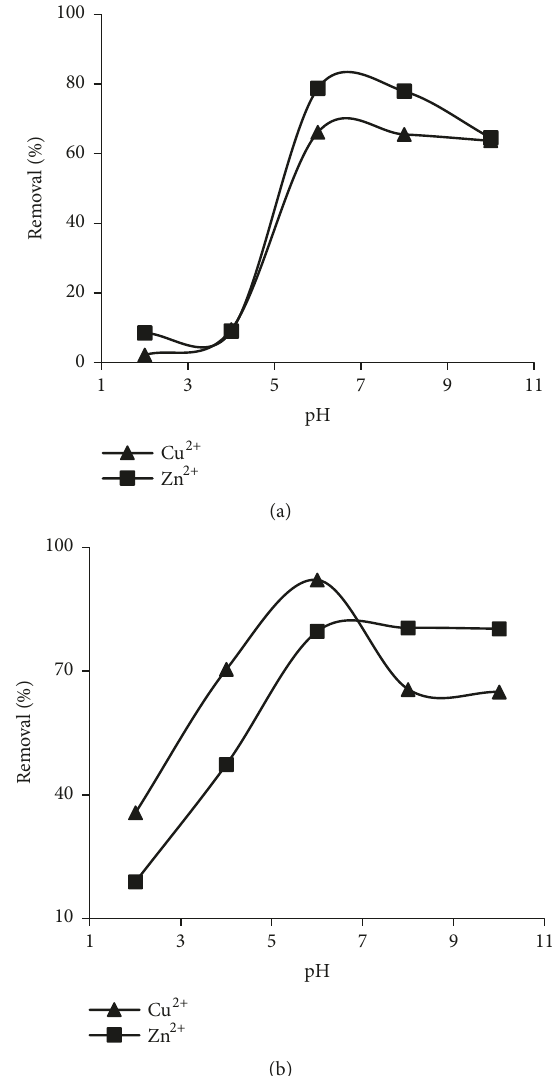
Figure 4: Effect of pH on metal ion removal using (a) EC and (b) Fe 2 O 3